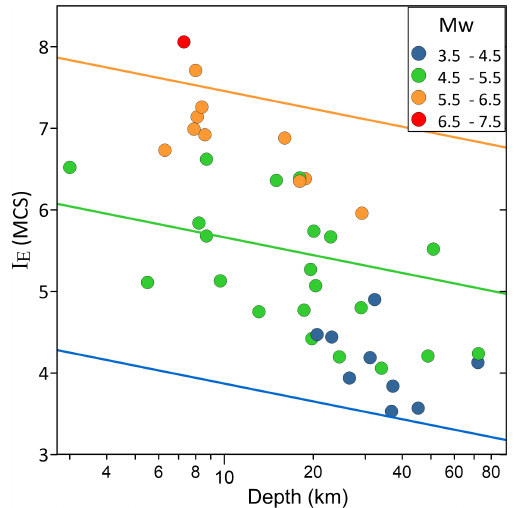
Figure 9. Magnitude as a function of the natural logarithm of depth and expected intensity at the epicenter I E for all earthquakes in the learning set (colored dots). The multiple regression function (Eq. 4) is shown with colored lines of equal magnitude for M w 4.0 (blue), M w 5.0 (green), and M w 6.0